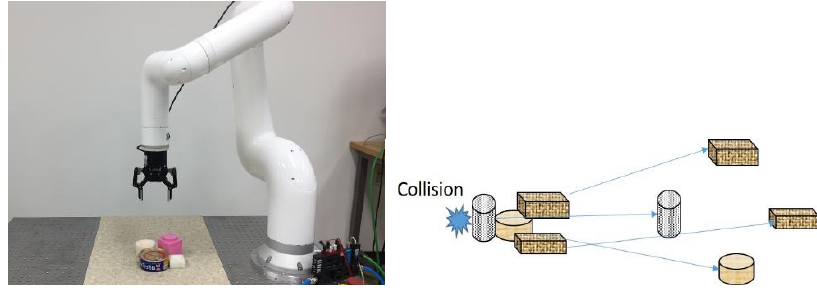
Figure 2. Concept of scattering based object singulation.